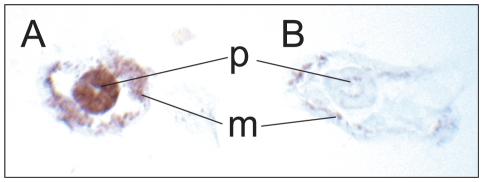
GFP detection in polg-1(ok1548)/mIn1 animals with DAB immunodetection system.
polg-1(ok1548)/mIn1 animals carrying a GFP-labeled balancer chromosome with pharyngeal muscle and gut expression, analyzed at day 1 of adulthood in frozen sections. Transverse sections through head. (A) GFP-positive pharynx, i.e. heterozygous or wild type for polg-1(ok1548). (B) GFP-negative pharynx, i.e. homozygous for polg-1(ok1548). m- body wall, p-pharynx. Anti-GFP specifically labels GFP-expressing tissues.